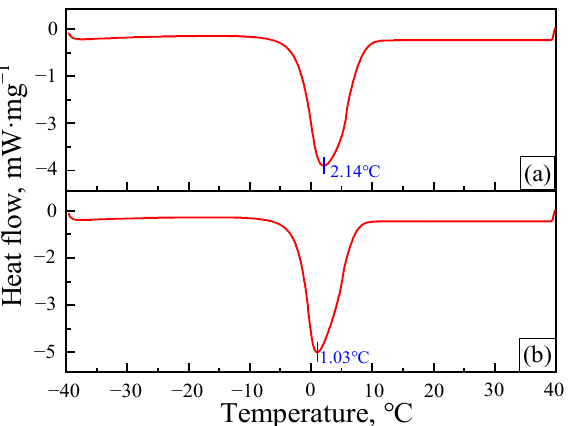
Figure 7. DSC curves for different gel samples: ( a ) G3515 gel without nanoparticles; ( b ) G3515 gel with 1 wt% nanoparticles.